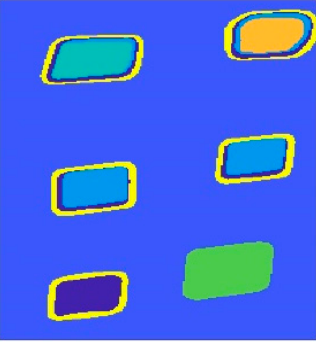
Figure 9. Coloring result of clustering.